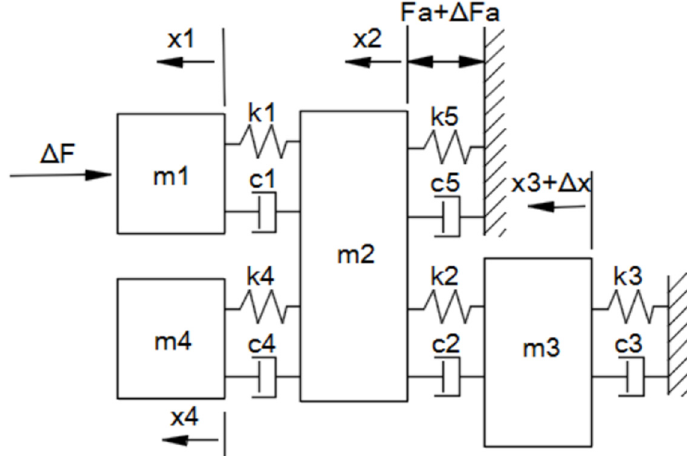
Figure 2. Lumped-parameter model of the positioning